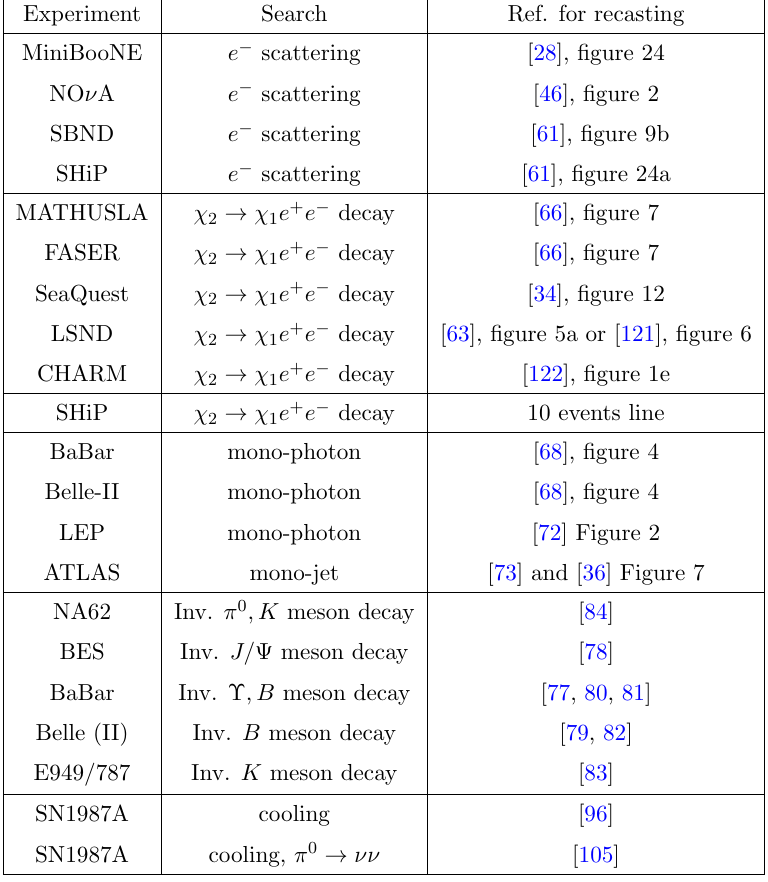
Table 7 . List of experimental searches currently implemented, along with some details about the process. Note that for SHiP decay limits, the 10-event limits are obtained directly using the tools described in this